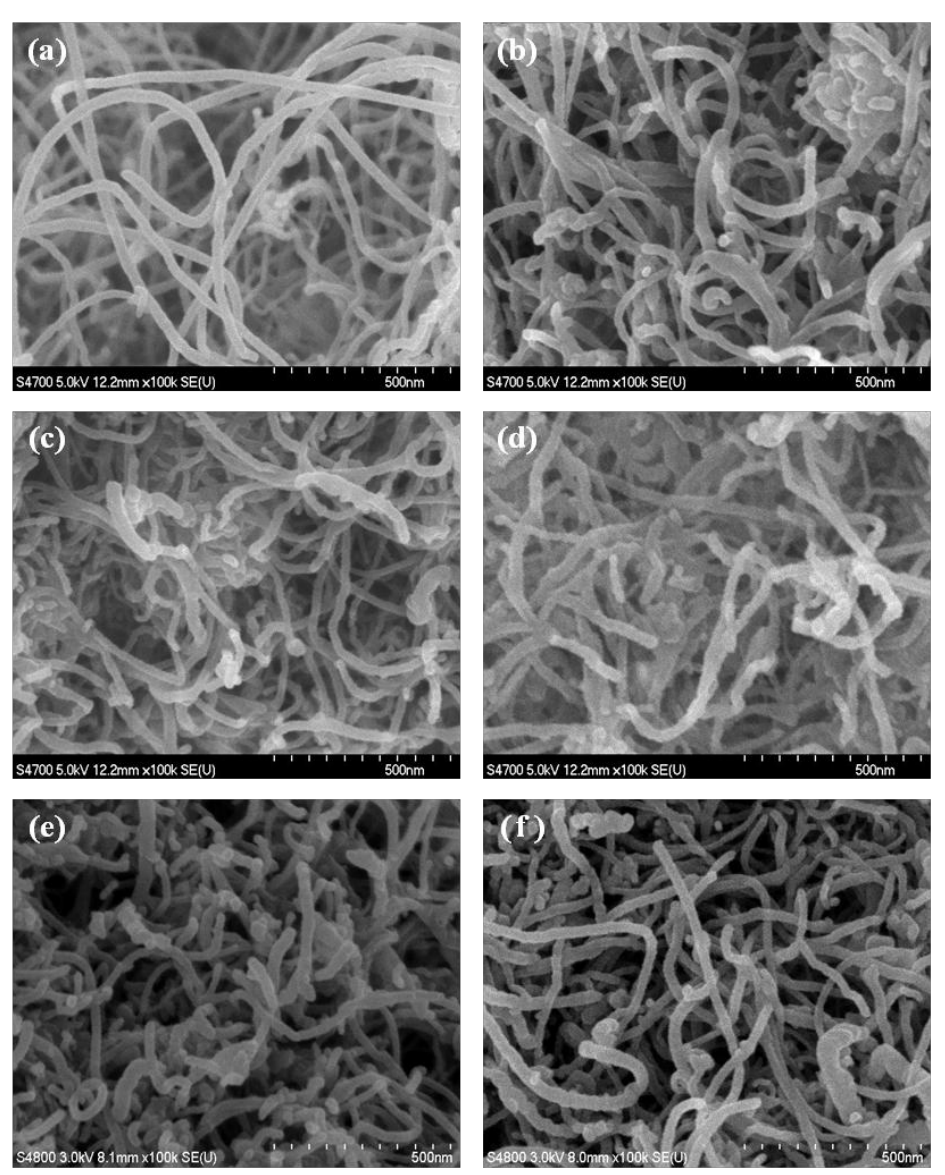
Figure 2. SEM images of ( a ) pristine CNTs, ( b ) SC104, ( c ) SC105, ( d ) SC107, ( e ) SC204, and ( f )